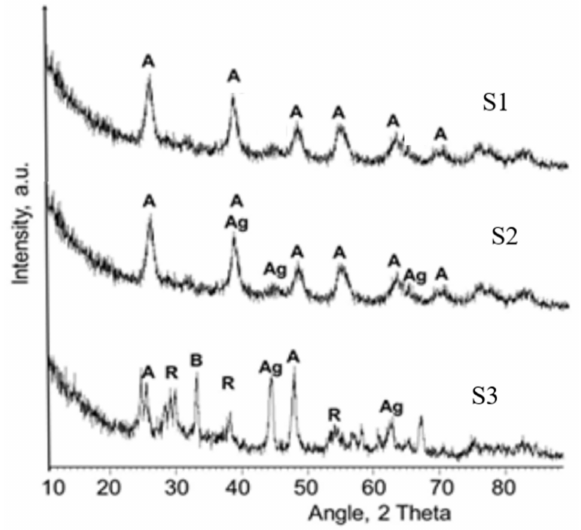
Figure 1. XRD patterns of the samples. A—anatase, R—rutile, B—brookite and